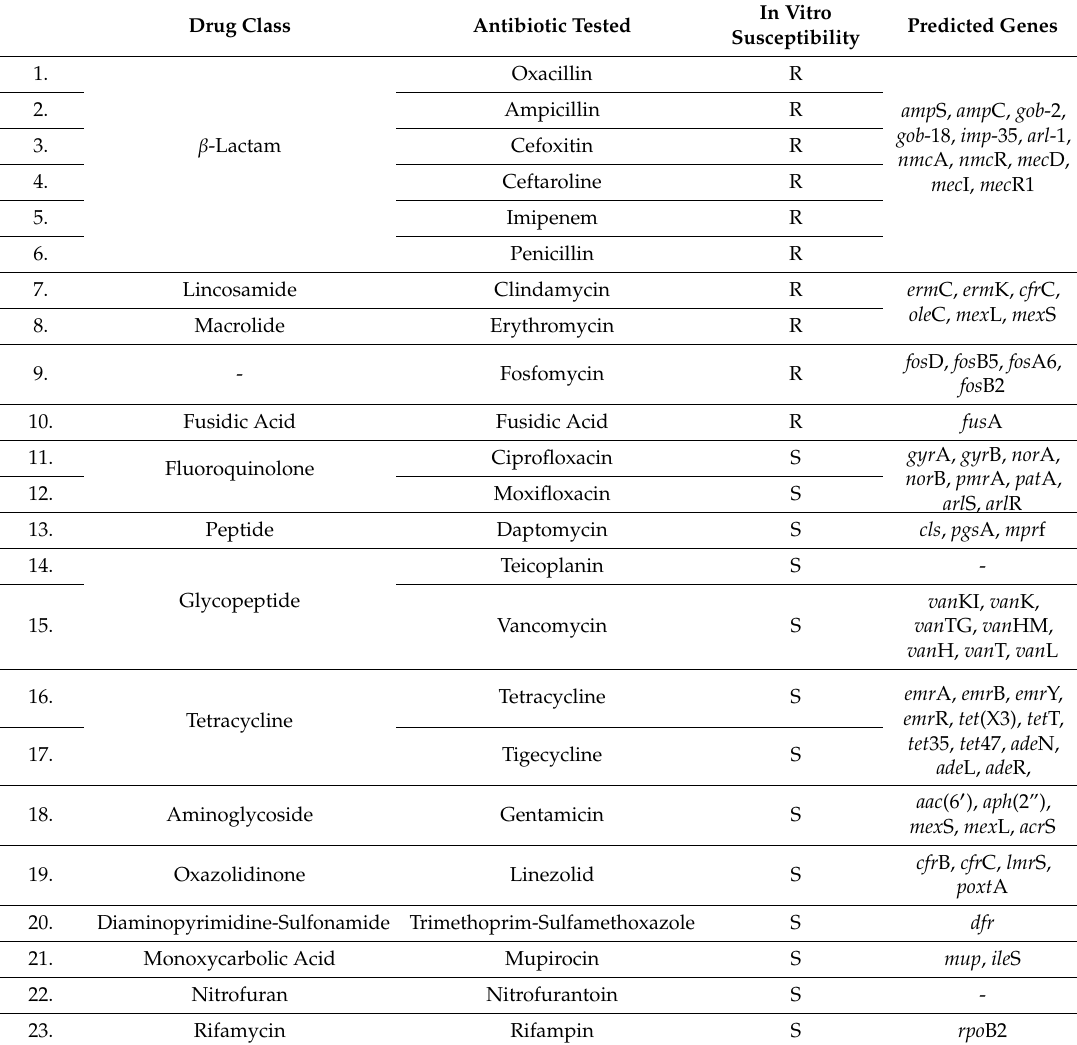
In vitro antibiotic susceptibility of Staphylococcus arlettae (SAR) Bari and correlated predicted